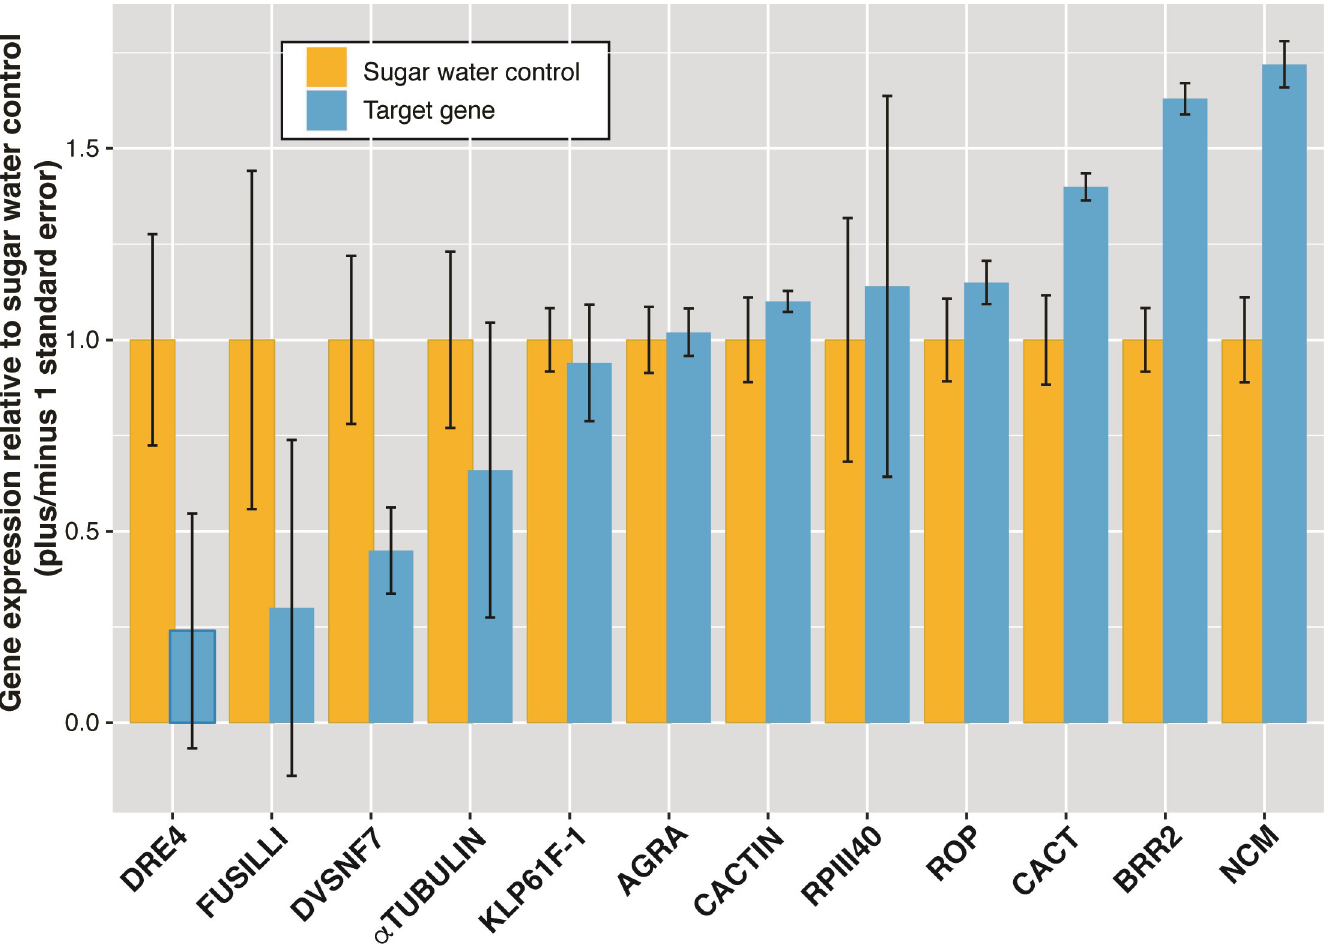
Fig 4. Relative gene expression for P . dominula wasps 48 h following dsRNA injections. Twelve different gene targets were injected into the wasps. Each bar represents the mean expression value pooled for five wasps and the SE compared to five control wasps injected with water.